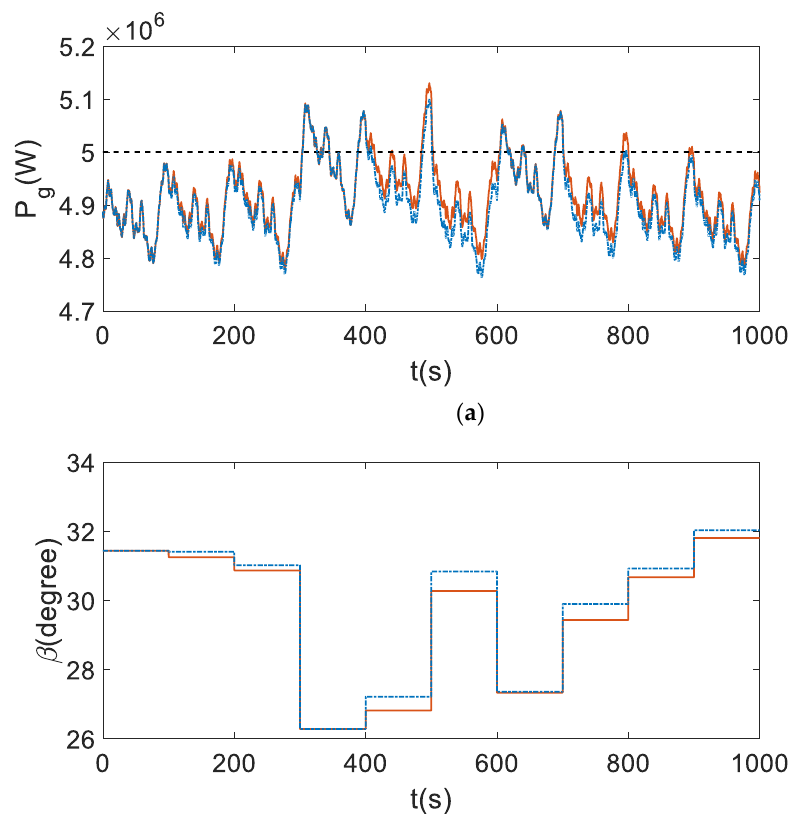
Figure 17. ( a ) Output power P g and ( b ) pitch angle β of WPGS for the robust MPC (red solid line) and stochastic MPC (blue dotted line) using FAST